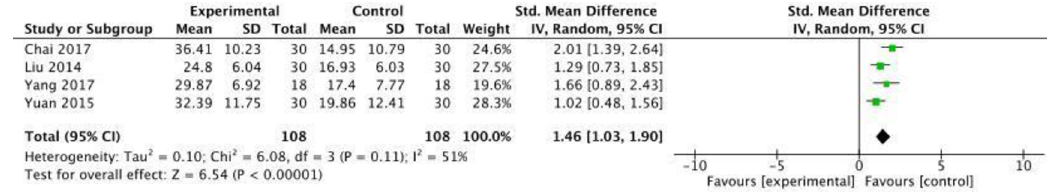
Fig 11. Meta-analysis of fire acupuncture versus acupunture for spasticity after stroke in B1.